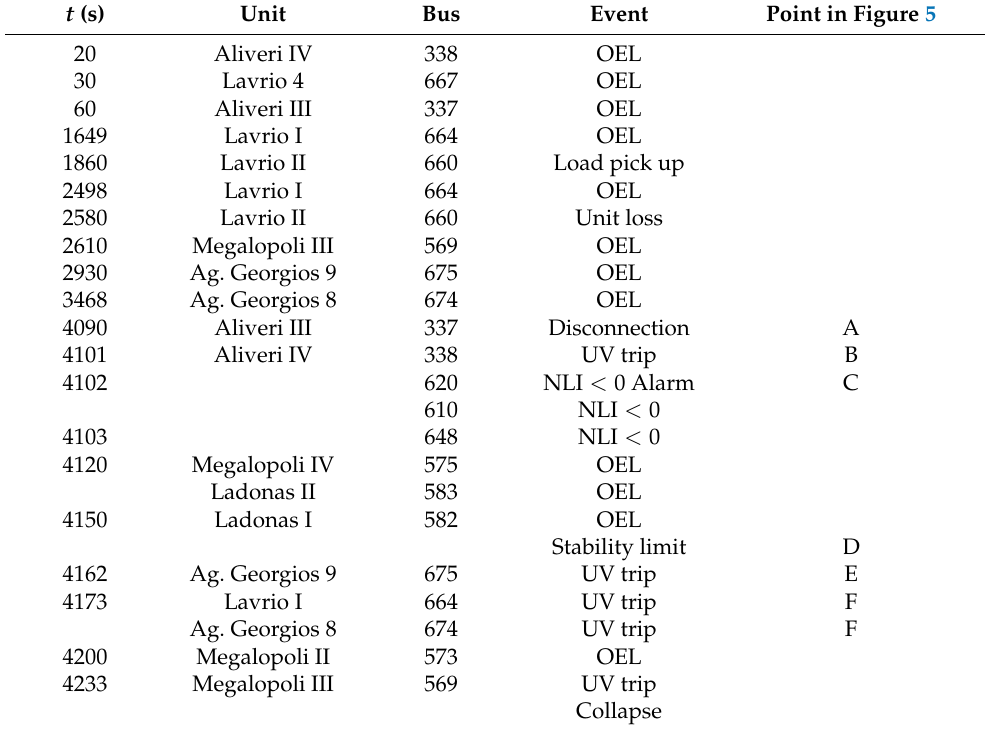
Table 2. Sequence of events in unstable